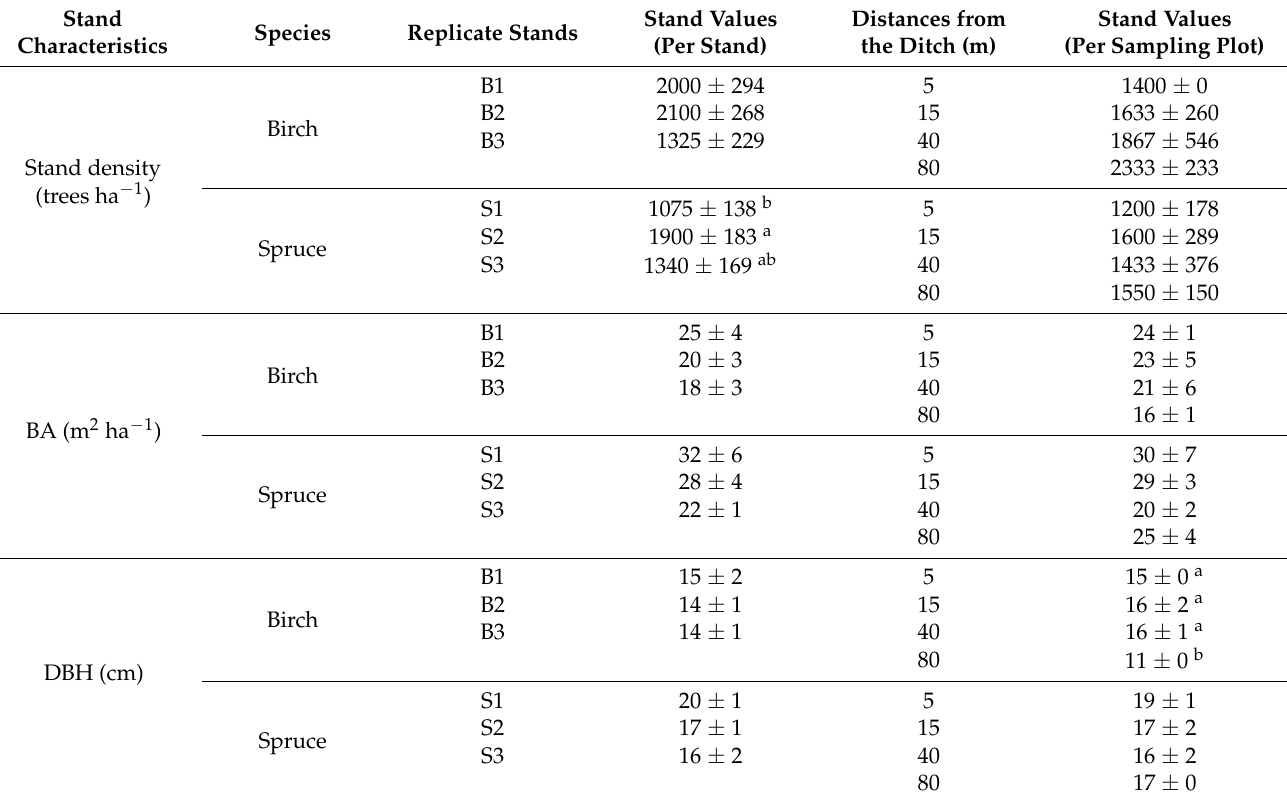
Table 2. Means ± standard errors of the stand characteristics of four sampling plots per stand (B1–B3, birch stands; S1–S3, spruce stands) and of the three replicate stands per sampling plot at the distances of 5, 15, 40, and 80 m from the ditch. BA—basal area; DBH—diameter at breast height. Small letters show a statistically significant difference (one-way ANOVA, followed by Tukey’s HSD; p < 0.05) of the mean stand characteristics among three birch and three spruce stands, and also among four distances from the